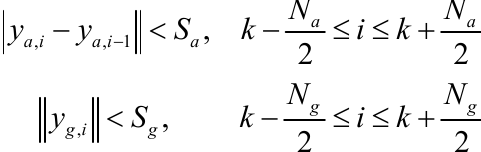
vision data are not available for each discrete time k since the sampling frequency of a camera is lower than that of inertial sensor data. Here vision data means that the image coordinates of marker corners. Difference between two images is measured by computing the average movement of image coordinates of marker